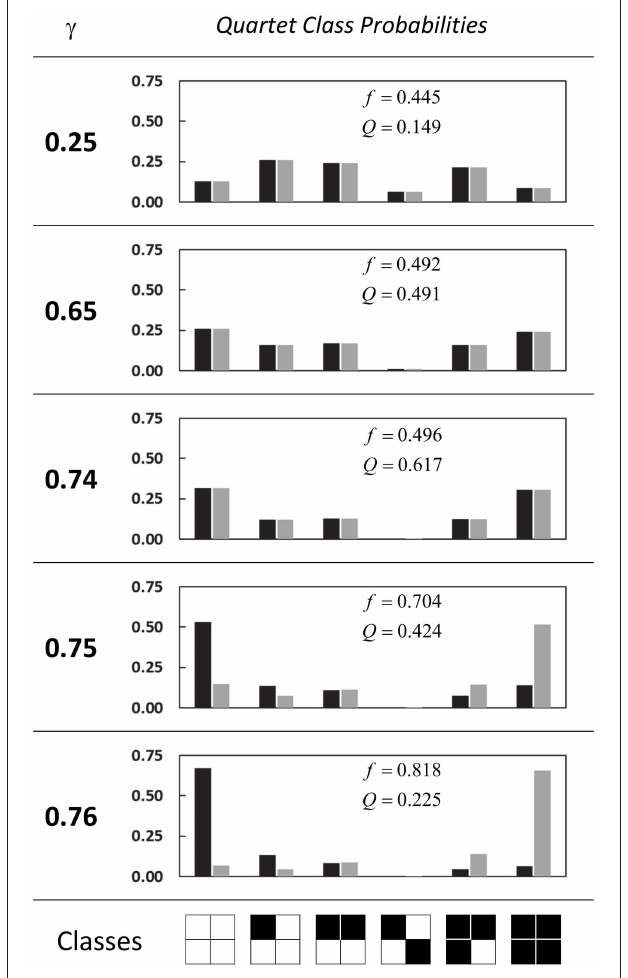
FIGURE 11 | Probability distributions for the six quartet classes. Each panel is for a different value of the recruitment probability γ , and vertical axes are the class probabilities. Each pair of black-gray bars is the probability for two consecutive timesteps at t = 500,000 for that class. Also given are the single-site probabilities f and clustering coefficients Q for the second timestep. In all cases α is held at 0.80.